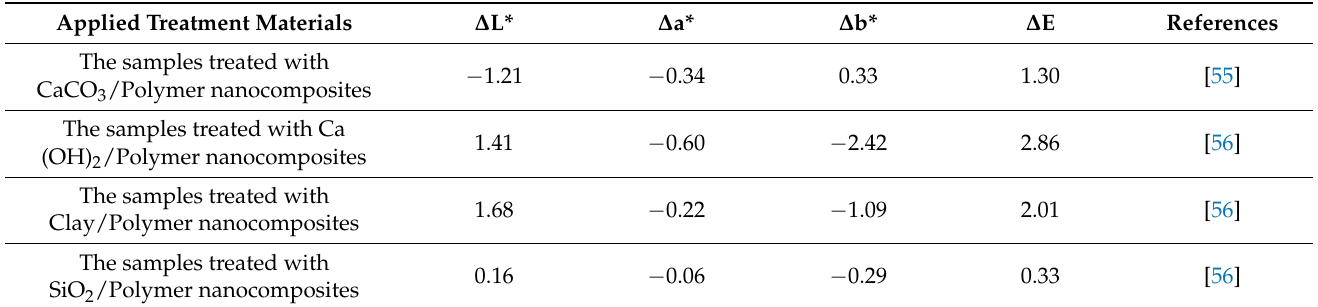
Table 12. Comparison among the colorimetric ∆ L*, ∆ a*, ∆ b* data, total color difference ∆ E* for different stones treated with CaCO 3 nanoparticles, reported in the